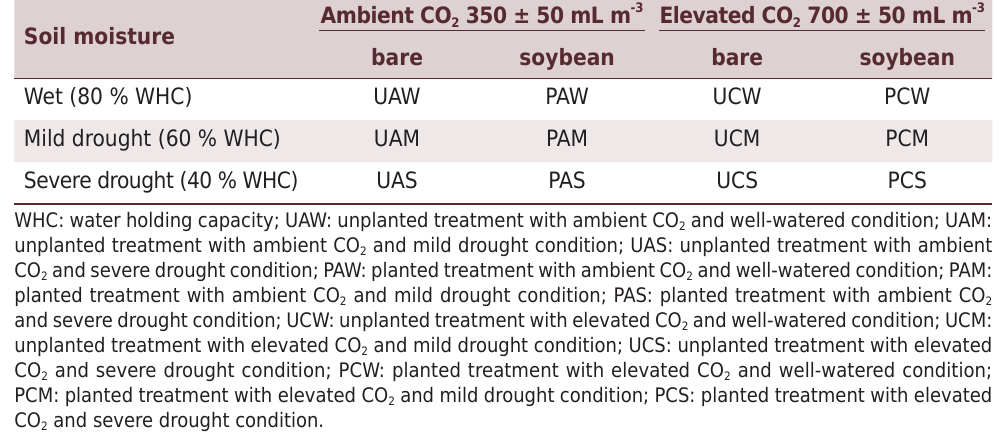
Table 1. Design of treatments: 3 × 2 × 2 factorial arrangement of soil moisture, elevated CO 2 level, and soil cover (with or without Glycine max plant) Soil moisture